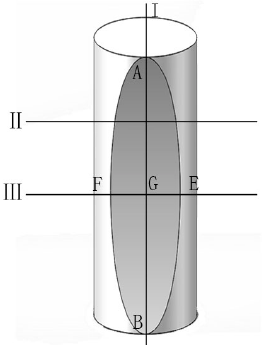
Figure 4. Metal circular tube plastic-deformation zone in the − y direction projection.